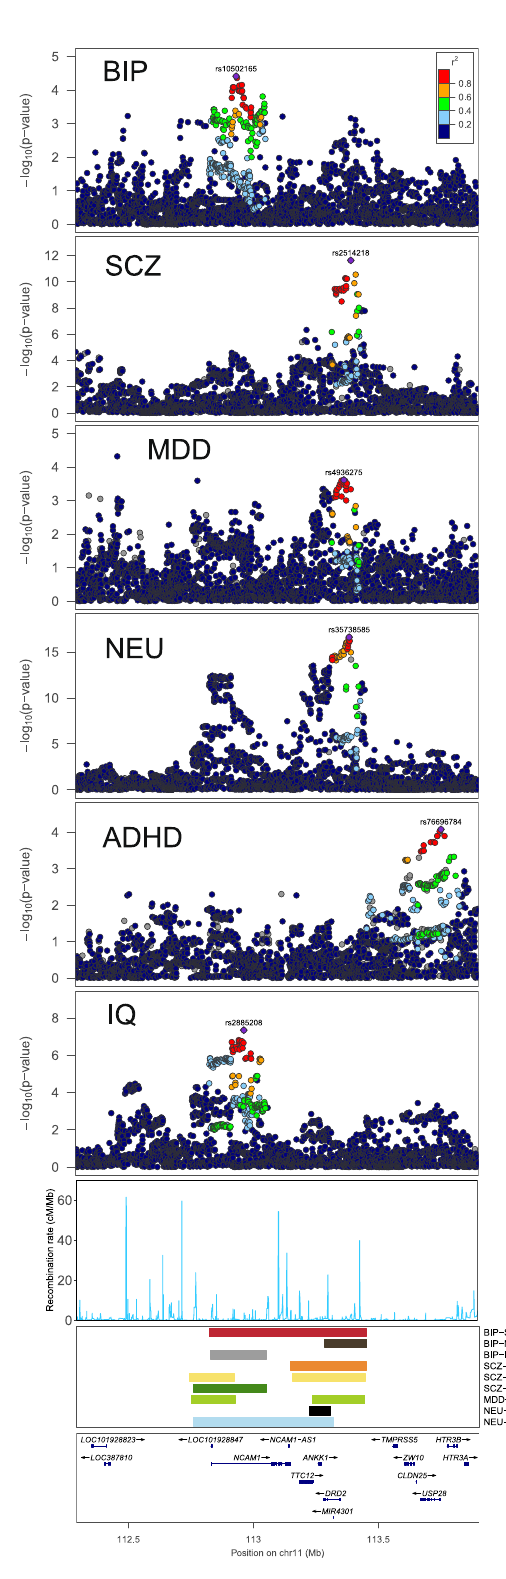
Fig. 6 Putative target genes for the hub region in chr11 shared by nine neuropsychiatric trait pairs. Locuszoom plot, recombination rate, and the gene names are provided. The colored band denote the location of the signi fi cant region and which trait pair is detected